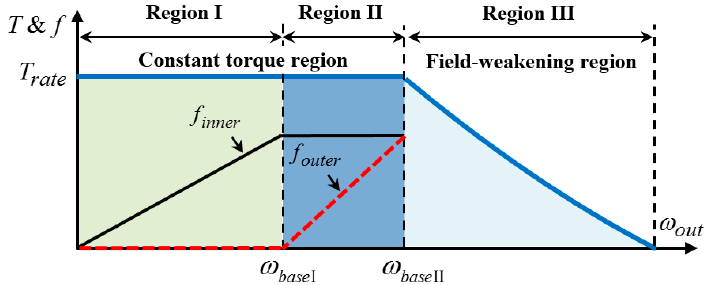
Figure 2. Speed-Torque curve of doubly fed magnetic geared motor with the individual frequency control in the